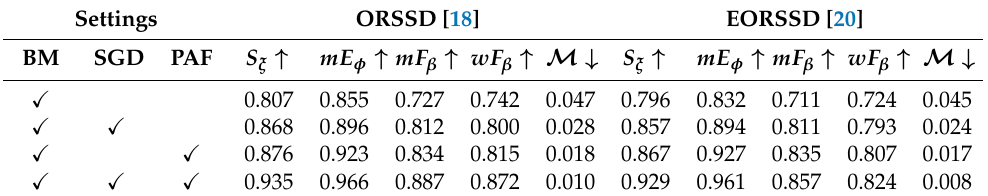
Table 4. Ablation study with different components combinations on the ORSSD and EORSSD datasets.